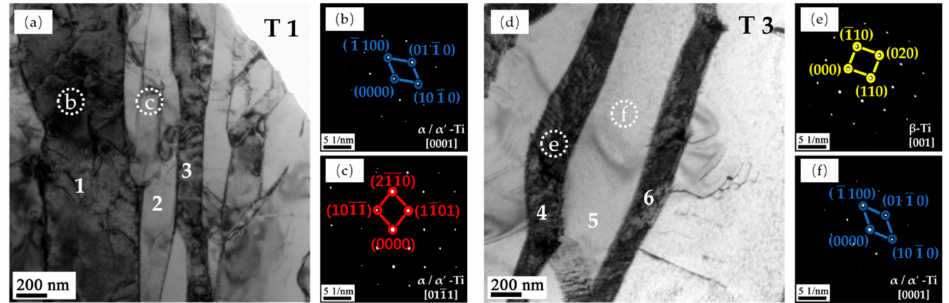
Figure 10. The TEM images of T1 and T3 samples showing two di ff erent types of laths: ( a )T1, ( b ) SADP image of marked point b, ( c ) SADP image of marked point c, ( d ) T3, and ( e ) SADP image of marked point e. ( f ) SADP image of marked point